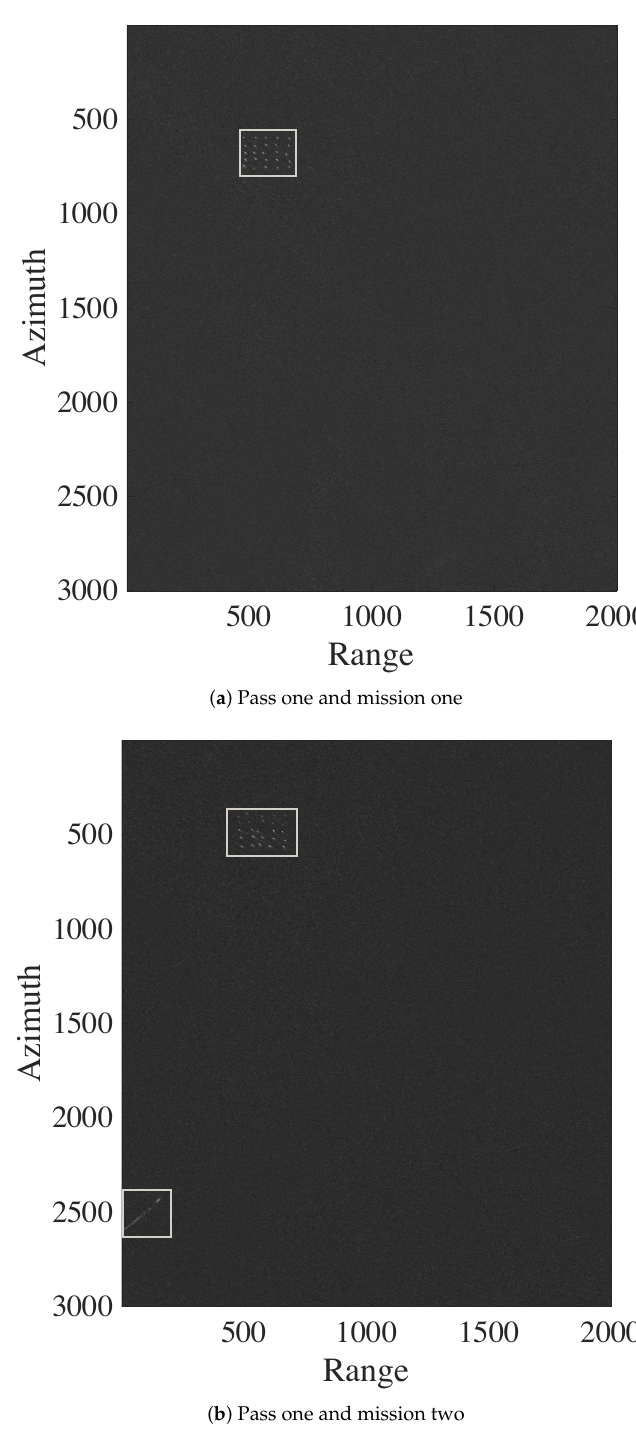
Figure 6. Subtraction of an interest image from the median ground scene prediction image. The areas highlighted by rectangles in the images represent the region with higher pixel